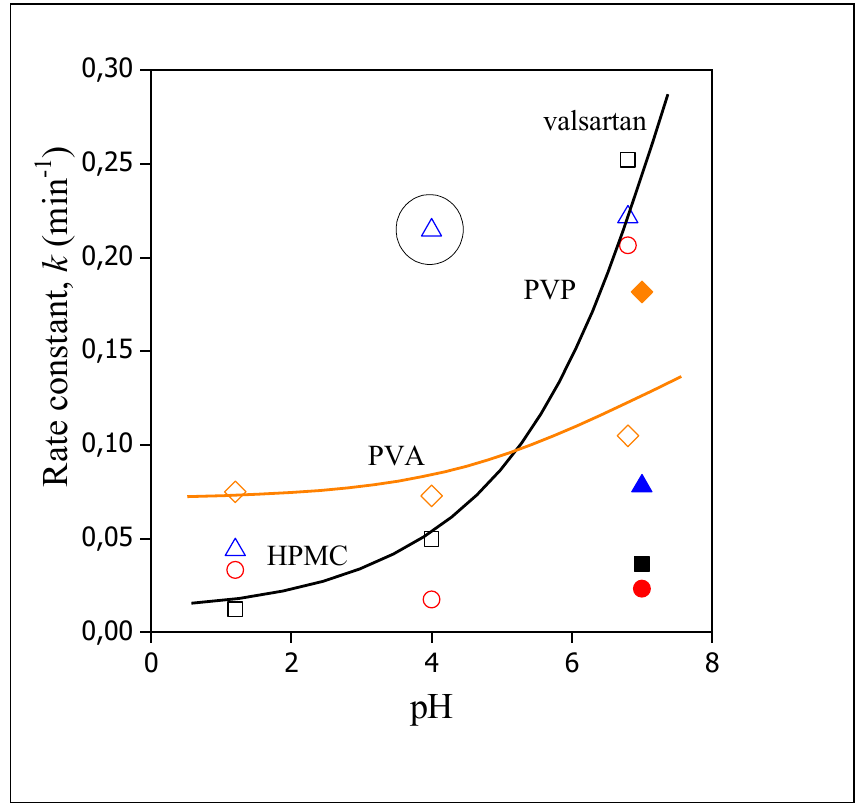
Figure 12. Effect of the pH of the dissolution medium on the rate of dissolution of valsartan and the release of the drug from electrospun fibers. Symbols: ( ) neat valsartan, ( ) HPMC, ( ) PVA, ( ) PVP; full symbols indicate dissolution into distilled water.